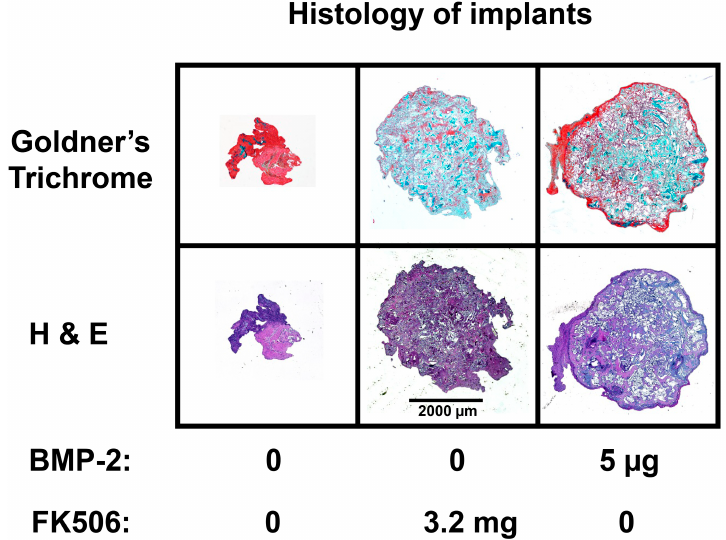
Figure 8. Representative images of subcutaneous collagen disk implants (4×). After four weeks, the implants were removed and embedded into paraffin. The samples were cut into 5 µm thick sections and stained with hematoxylin and eosin (H&E) and Goldner’s trichrome (green/turquoise represent bone, and red represents collagen and muscle).